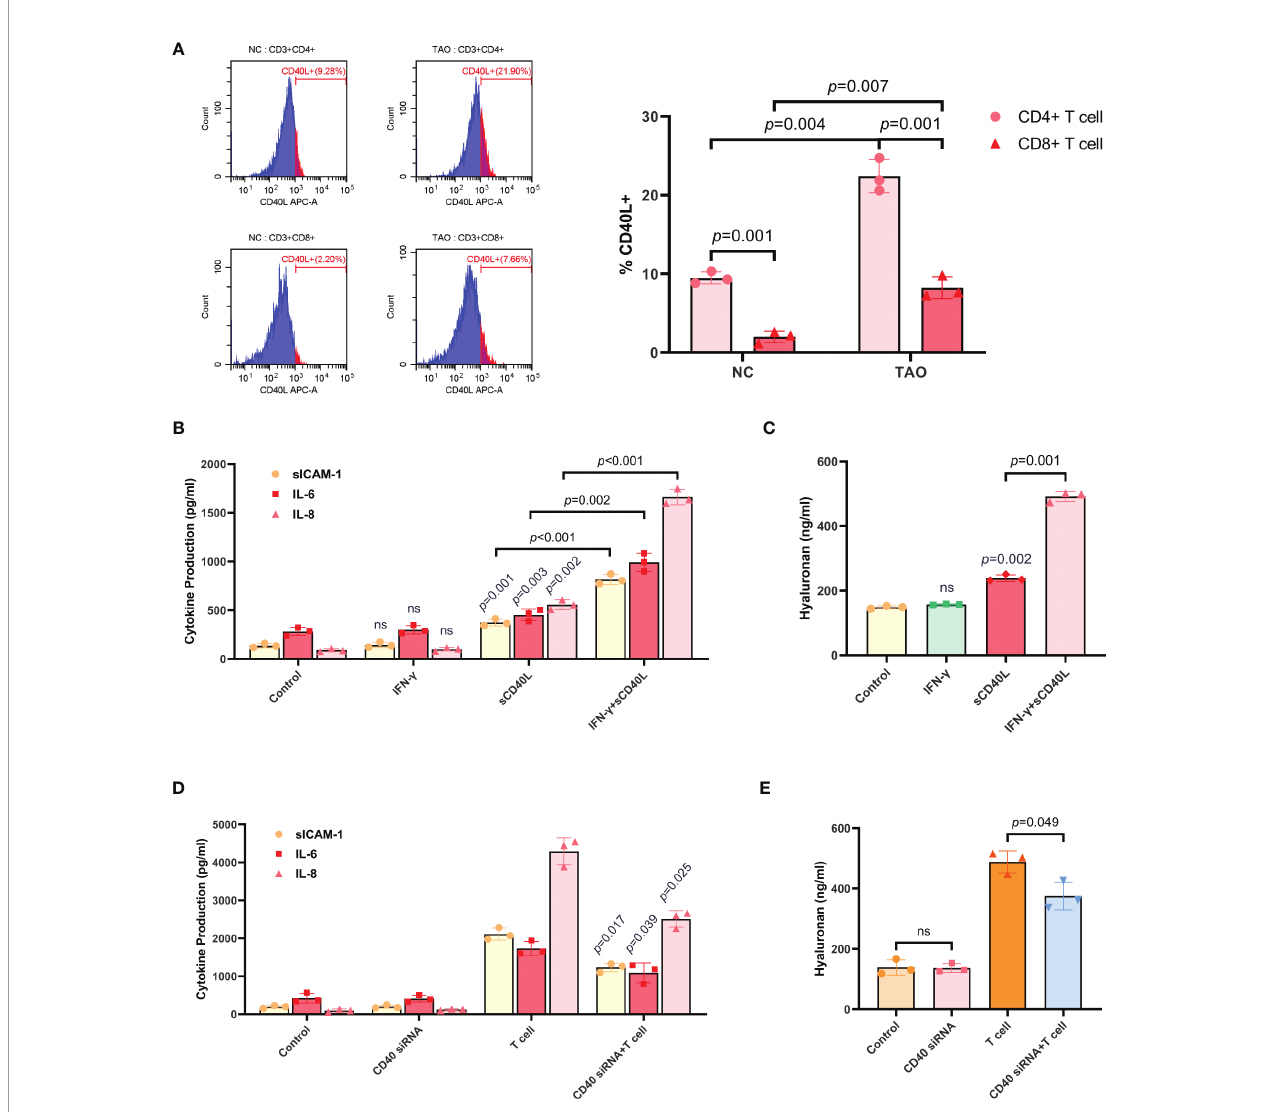
FIGURE 3 | T cells induced the production of sICAM-1, IL-6, IL-8, and HA in TAO-OFs via the CD40-CD40L pathway. (A) FCM of lymphocytes isolated from peripheral venous blood of TAO patients compared to negative controls demonstrating differential proportion of CD40L+ cells in CD4+ T cells and CD8+ T cells. (B, C) TAO-OFs were treated with PBS, IFN- g (100 U/mL), sCD40L (100 ng/mL), and IFN- g combined with sCD40L for 48 hours, respectively. And the supernatants were subjected to analysis of sICAM-1, IL-6, IL-8, (B) and HA (C) contents by ELISA. (D, E) TAO-OFs and CD40-knockdown TAO-OFs were co-cultured with autologous T cells (OFs: T cells = 1: 10) for 48 hours or not, and the supernatants were subjected to ELISA to detect the production of sICAM-1, IL-6, IL-8, (D) and HA (E) . Data are expressed as mean ± SD of triplicates. ns: no signi fi cance. Representative of three independent experiments using cells from a different